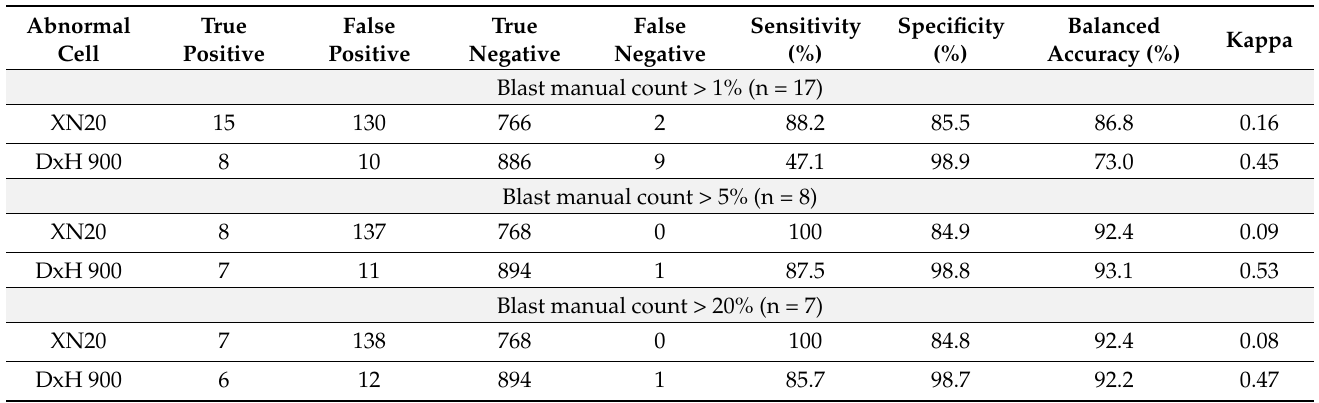
Table 6. Blast flag detection (reference method cut-off) sensitivity and specificity in the DxH 900 and the XN20.